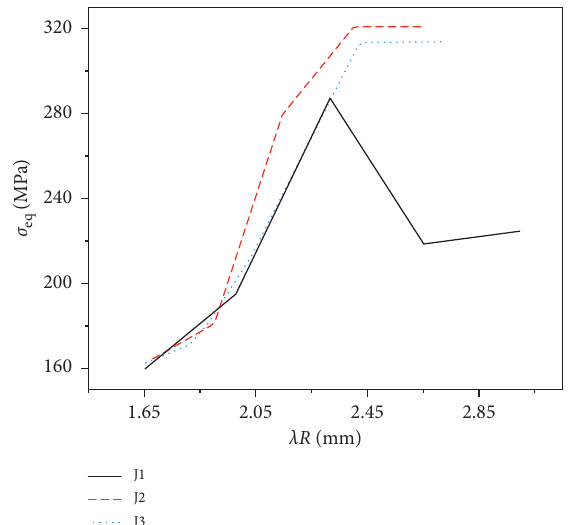
Figure 9: Distribution of σ eq along the radial direction in the joint at room